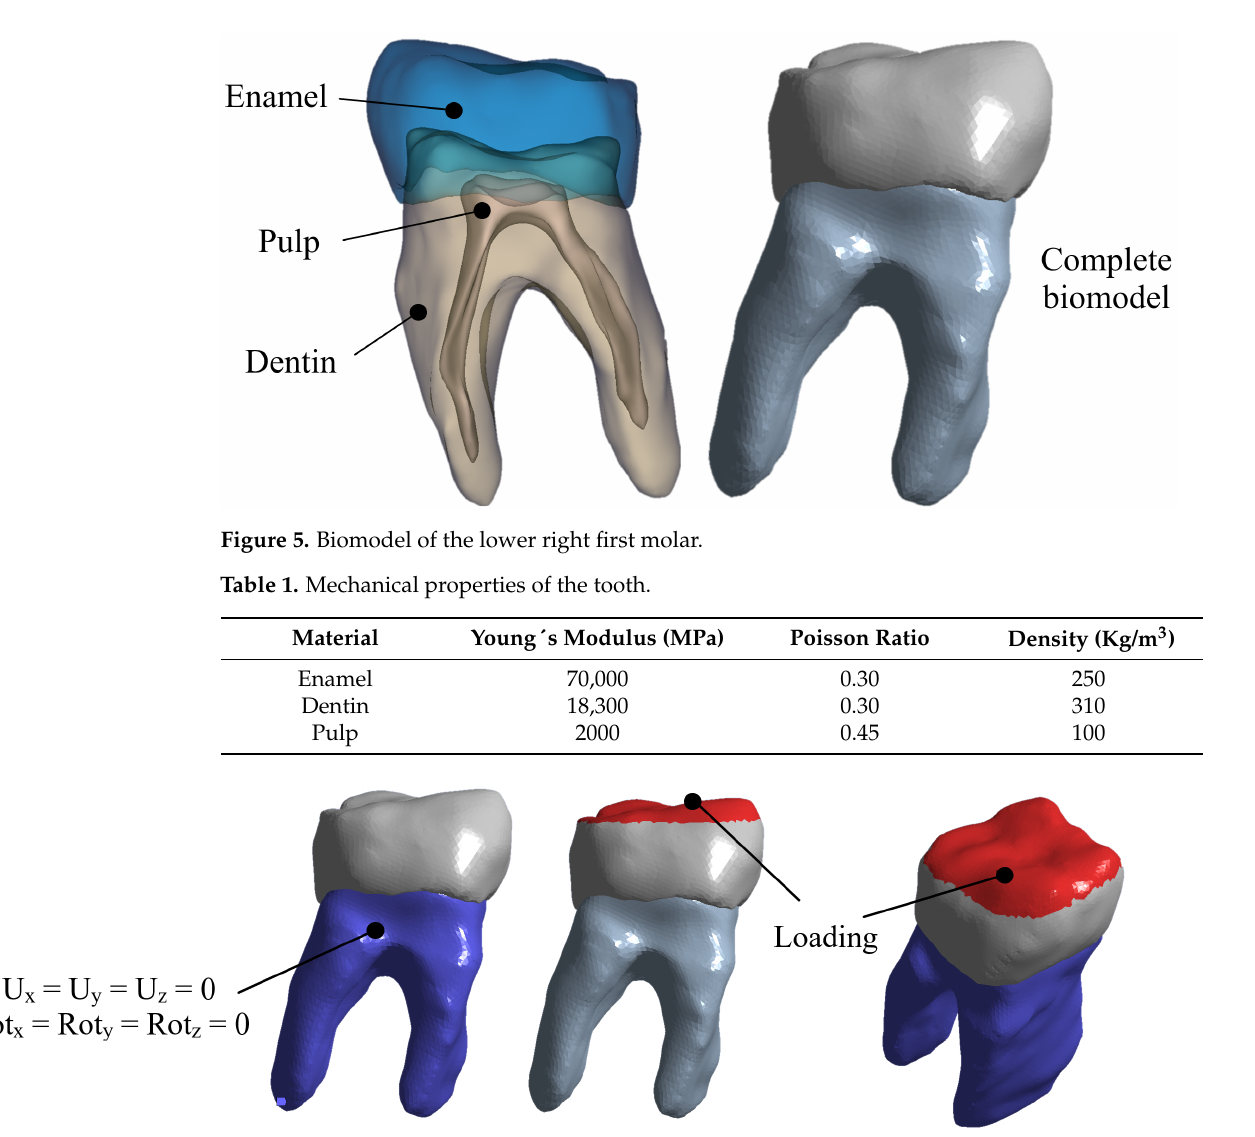
Figure 6. Boundary conditions and external loads on the